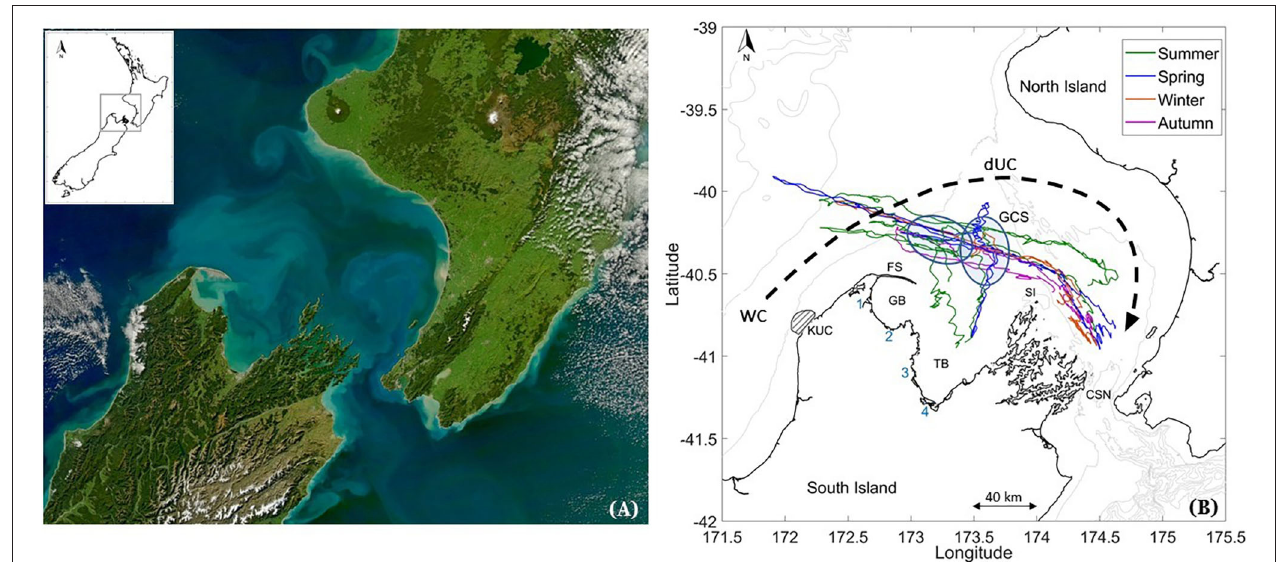
FIGURE 1 | Map of (A) True color of Greater Cook Strait region cropped from image of New Zealand obtained by NASA’s Aqua MODIS satellite for April 29, 2011; available on NASA’s earth observatory. Map of New Zealand in top left corner, with Greater Cook Strait region highlighted as gray box. (B) Map of Greater Cook Strait showing general circulation of the region (WC: Westland Current and DUC: d’Urville Current), locations of GB: Golden Bay, TB: Tasman Bay, KUC: Kahurangi upwelling cell (striped region), FS: Farewell Spit, SI: Stephen Island and glider tracks (line color indicating the seasonal affiliation of each glider survey). Hotspots of low salinity submesoscale features (North of Farewell Spit and middle of Greater Cook Strait) are plotted in blue circles. Numbers 1–4 indicate locations of river mouths of Arorere River, Takaka River, Motueka River, and Waimea/Wairoa River,